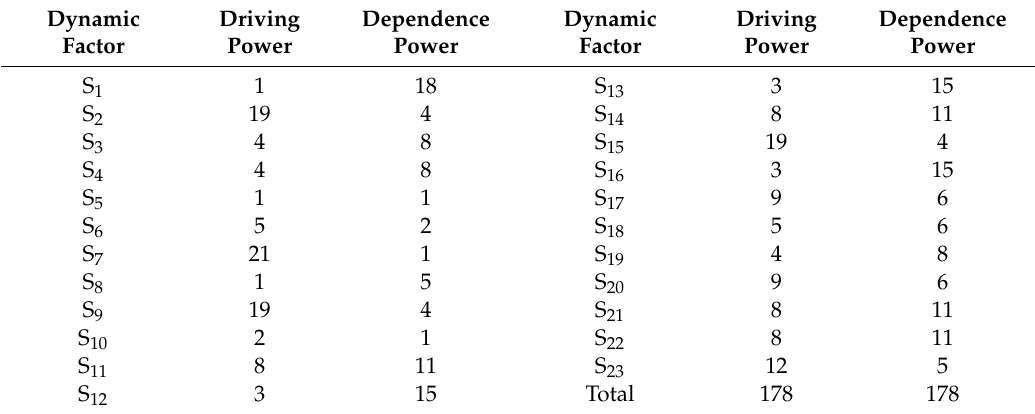
Table 7. Driving power and dependence power values of super-gentrification dynamic factors.